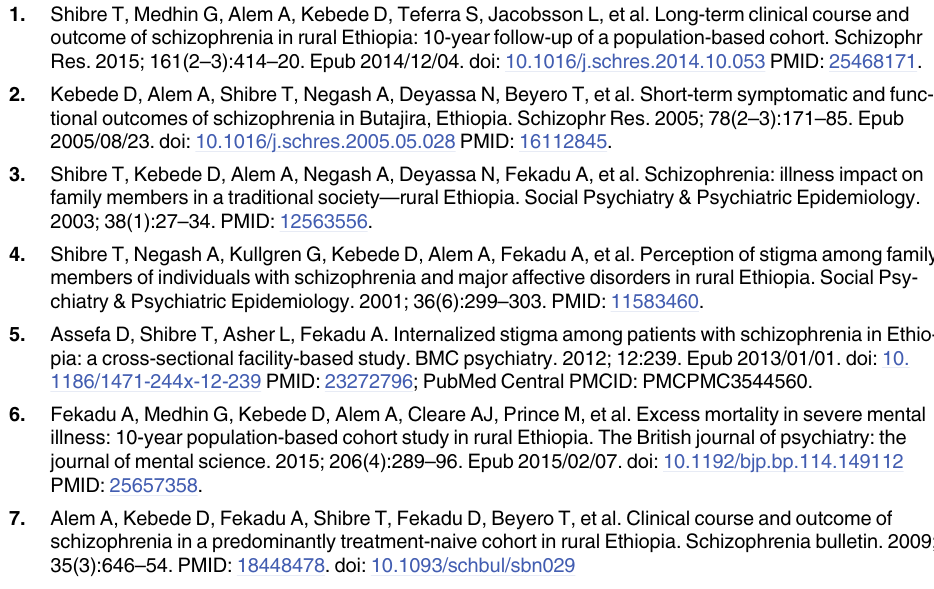
S1 Table. Summary of research questions, findings and impact on intervention design.